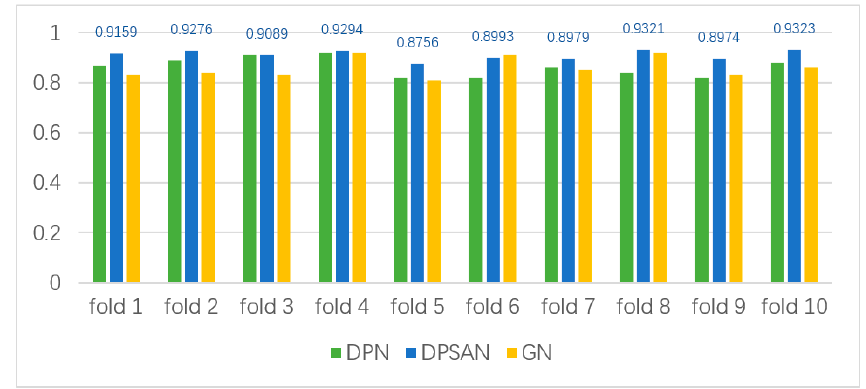
Figure 10. Performance of different component solutions on CK+. Table 4. Evaluation of all components of DPSAN on the CK+ dataset. Global